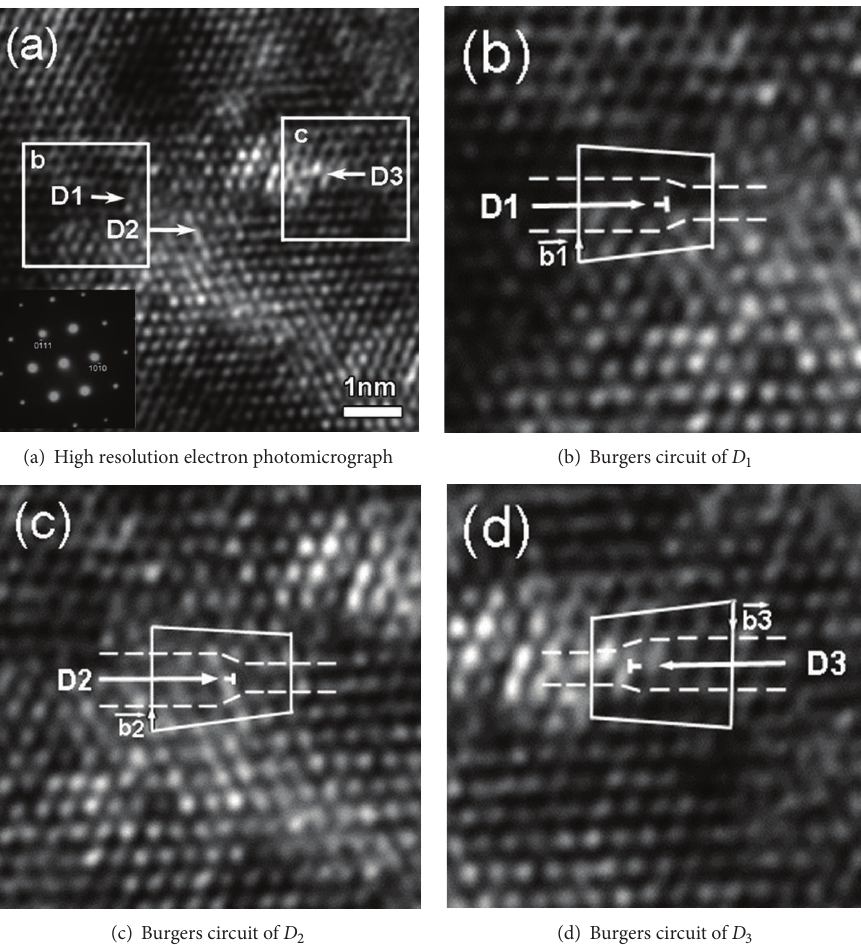
Figure 8: High resolution electron photomicrograph of dense-hexagonal structure.